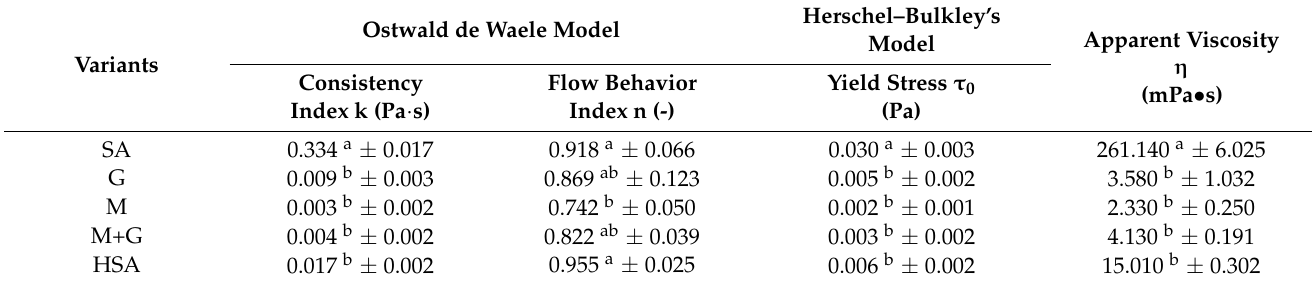
Table 2. Flow properties.